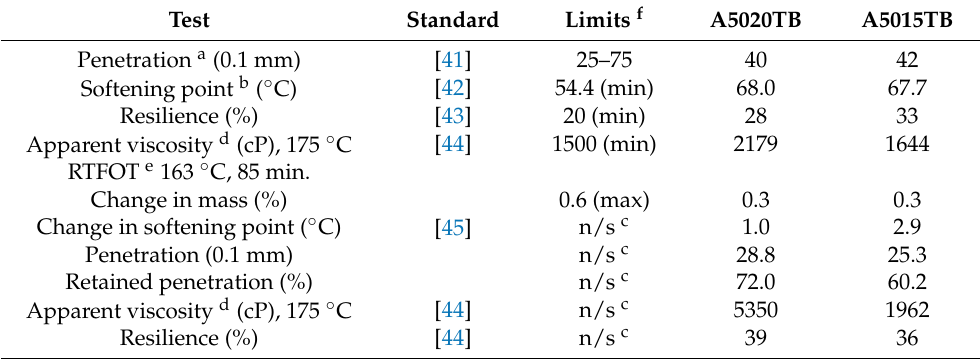
Table 6. Results of the terminal blend asphalt rubber characterization tests.